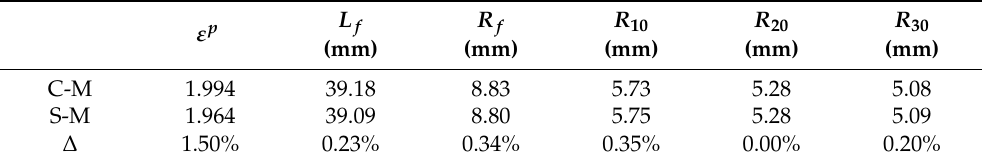
Figure 11. Equivalent plastic strain contour-plots of the complete model and simplified model for Taylor test. ( a ) Equivalent plastic strain contour-plot of the complete model; ( b ) Equivalent plastic strain contour-plot of the simplified model. Table 3. Comparison between the complete model (C-M) and simplified model (S-M) for Taylor compression